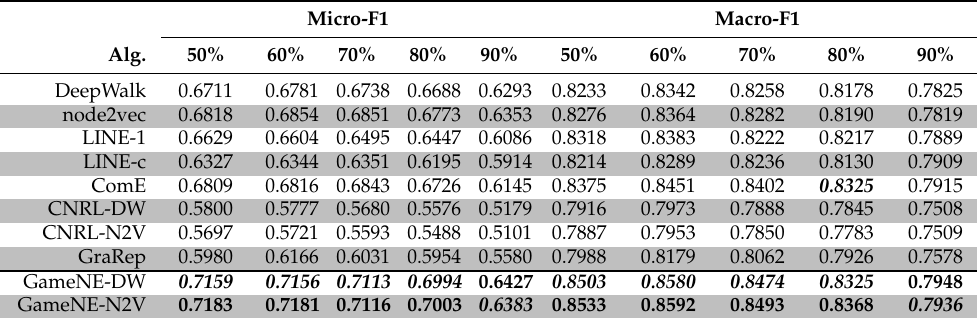
Table 7. Micro- and Macro F1-Scores of Multi-Label Classification, Network on = 20%.